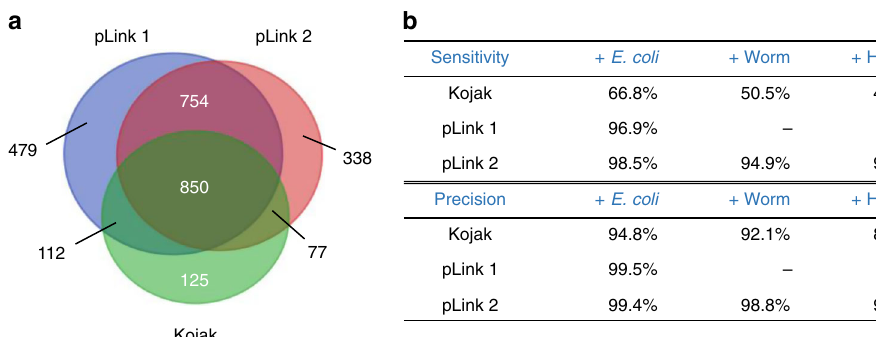
Fig. 4 Performance evaluation on the SCF(FBXL3)-BS3 dataset. a A real-world protein complex sample was searched using Kojak, pLink 1, and pLink 2. A total of 850 cross-linked PSMs were identi fi ed consistently by the three engines; these were used to be a new and fair standard dataset. b The sensitivities and precisions of the three engines. “ + E. coli ” database contains sequences from 146 target proteins and the E. coli whole proteome database and “ + Worm ” and “ + Human ” are similar to “ + E. coli ” . pLink 1 did not fi nish searching against the worm or the human entrapment databases within 1 week on